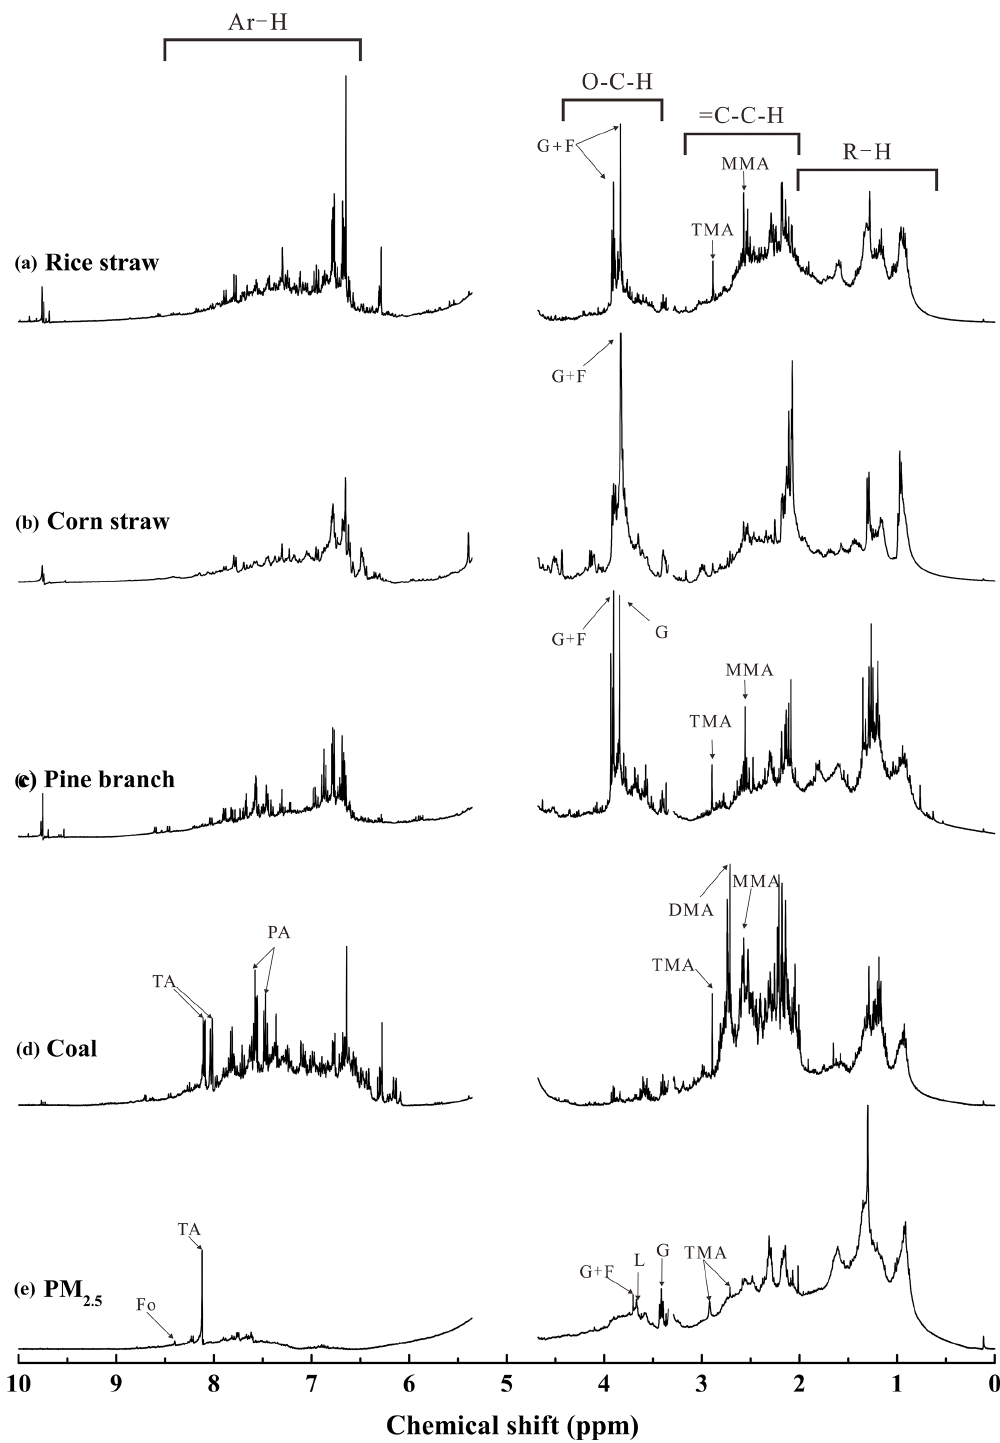
Figure 4. 1 H NMR spectra of HULIS in smoke PM 2 . 5 from combustion of rice straw (a) , corn straw (b) , pine branch (c) , and coal (d) , and in ambient PM 2 . 5 (e) . The segments from 3.30 to 3.35 and 4.80 to 5.40ppm were removed from all NMR spectra due to MeOH and H 2 O residues. The peaks were assigned to specific compounds as follows: formate (Fo), terephthalic acid (TA), phthalic acid (PA), glucose (G), fructose (F), trimethylamine (TMA), dimethylamine (DMA), and monomethylamine